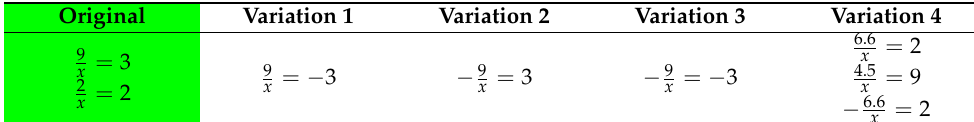
Table 7. Examples of type 6 equations and variations.